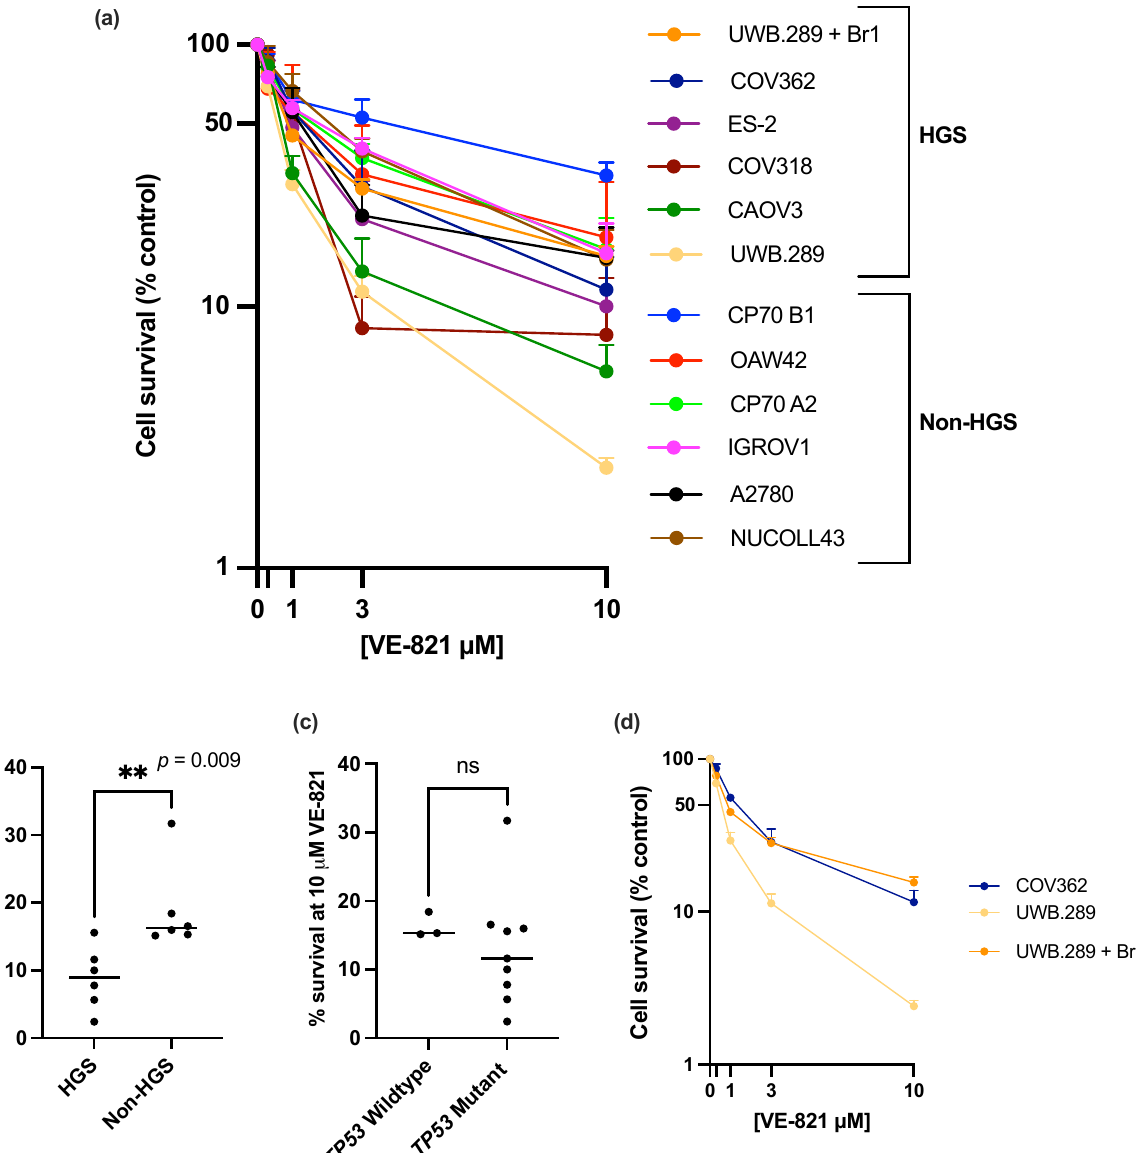
Figure 1. ( a ) Mean single agent cytotoxicity of VE-821 by colony survival assay. All data points are mean ± SEM (at least 3 independent experiments). ( b ) Median percentage cell survival at 10 µ M VE-821 of HGS and non-HGS cell line is indicated with horizontal black line. ** p < 0.01 (Mann– Whitney test). ( c ) Median percentage cell survival at 10 µ M VE-821 of TP53 WT or mutant cell lines is indicated by horizontal black line. ns, p > 0.05 (Mann–Whitney test). TP53 Wildtype cell lines; OAW42, NUCOLL43, A2780, TP53 mutant cell lines; IGROV1, COV318, COV362, CAOV3, ES-2, UWB1.289, UWB1.289 + Br1, CP70 A2, CP70 B1. ( d ) Single agent cytotoxicity of VE-821 in BRCA1 mutant cell lines COV362 and UWB1.289, and BRCA1 corrected cell line UWB1.289 + Br1. All data points are mean ± SEM (at least 3 independent